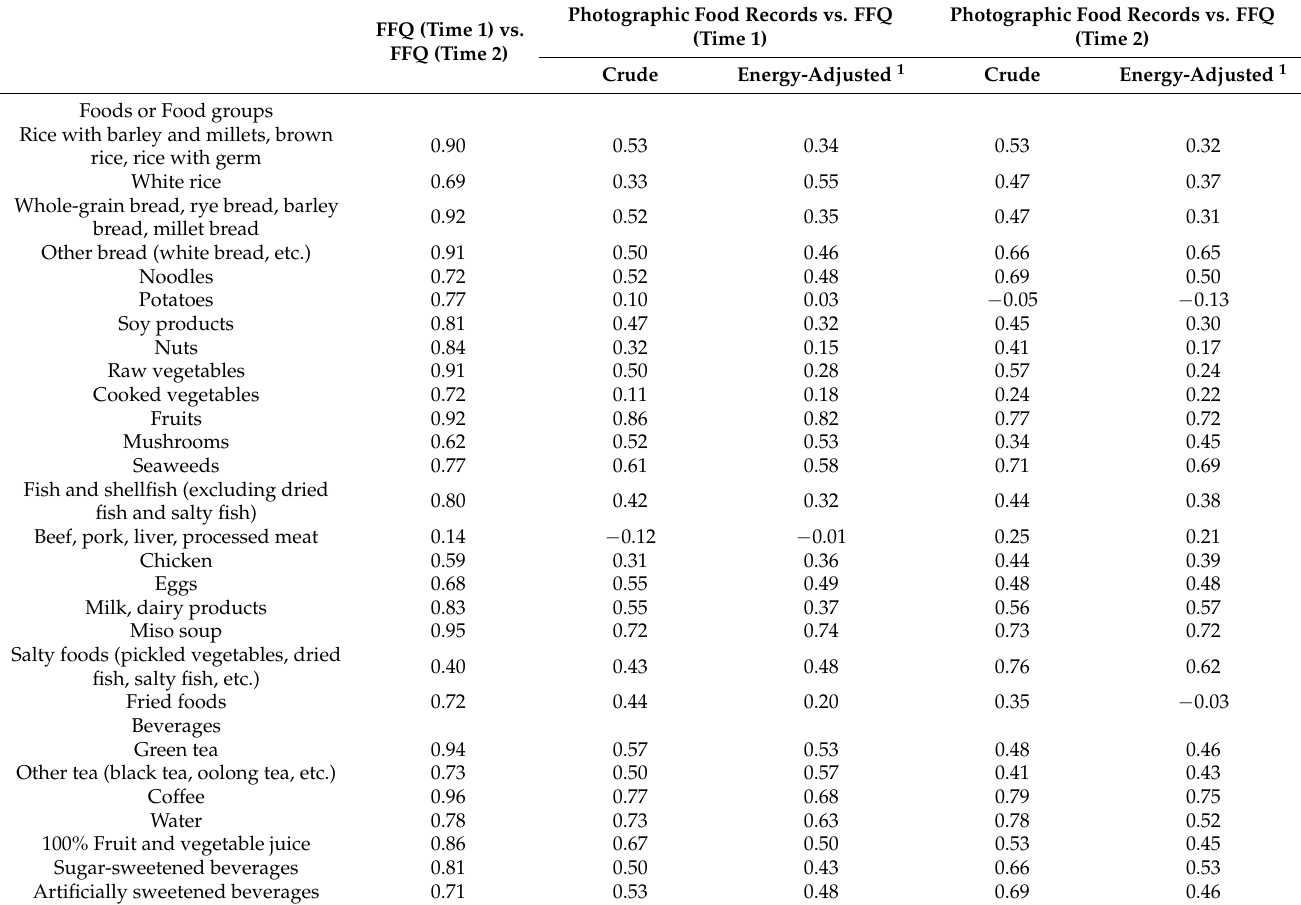
Table 2. Spearman correlation coefficients between consumption frequency of food groups based on two FFQs one week apart and food group intakes based on a 3-day photographic food record in 9 males and 15 females. FFQ (Time 1) vs. FFQ (Time